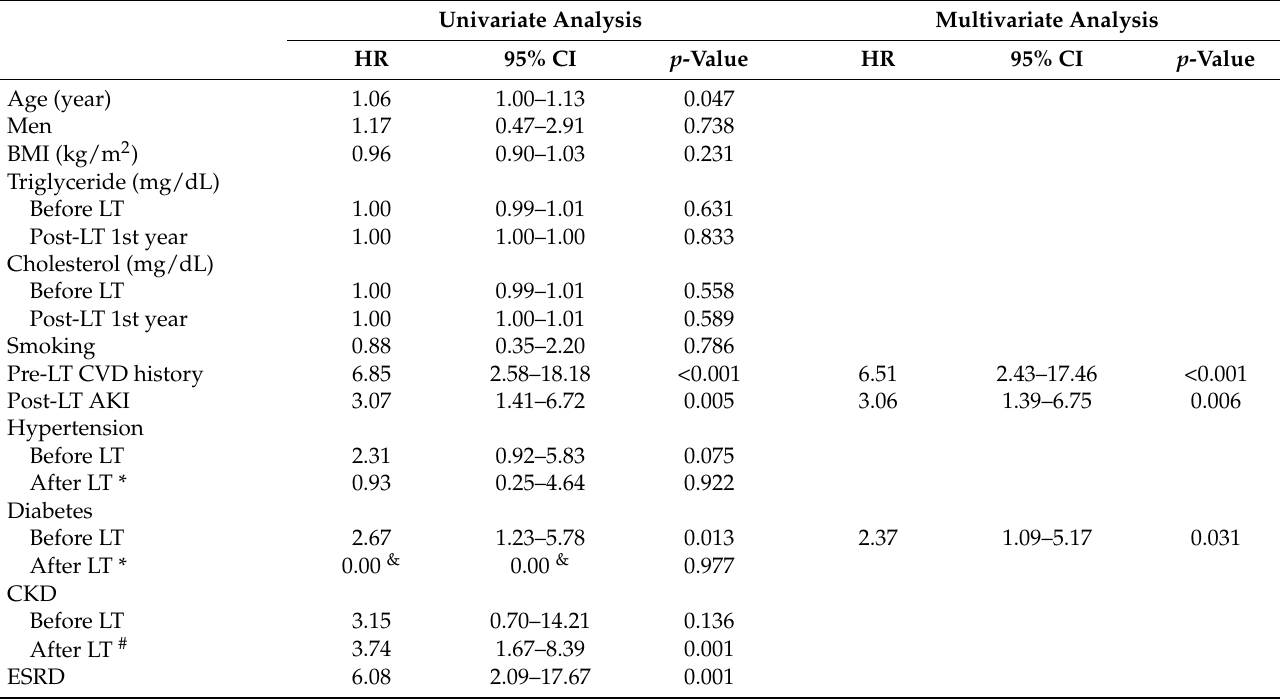
Table 3. Risk Factors of Major Adverse Cardiovascular Events after Living Donor Liver Transplanta- tion by Cox Regression